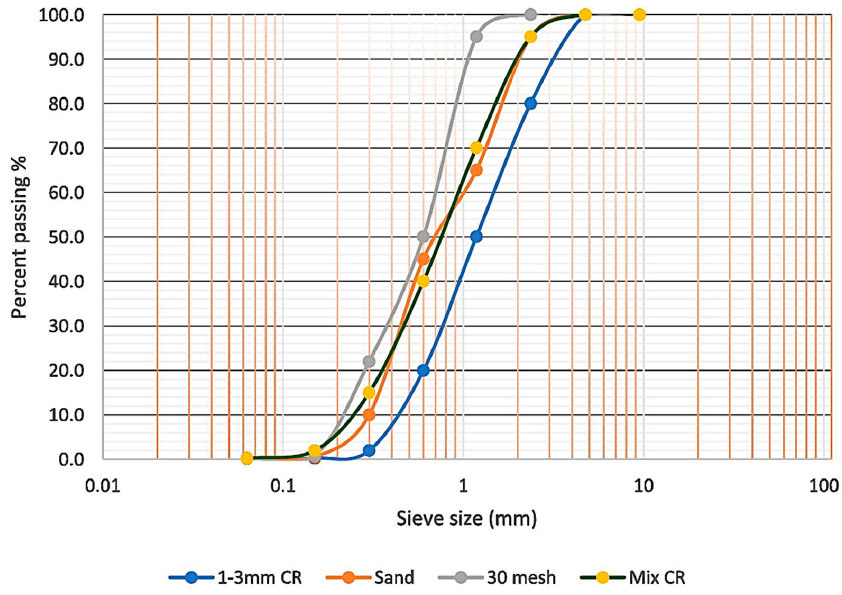
Figure 2. Grading curve of fine sand and crumb rubber.